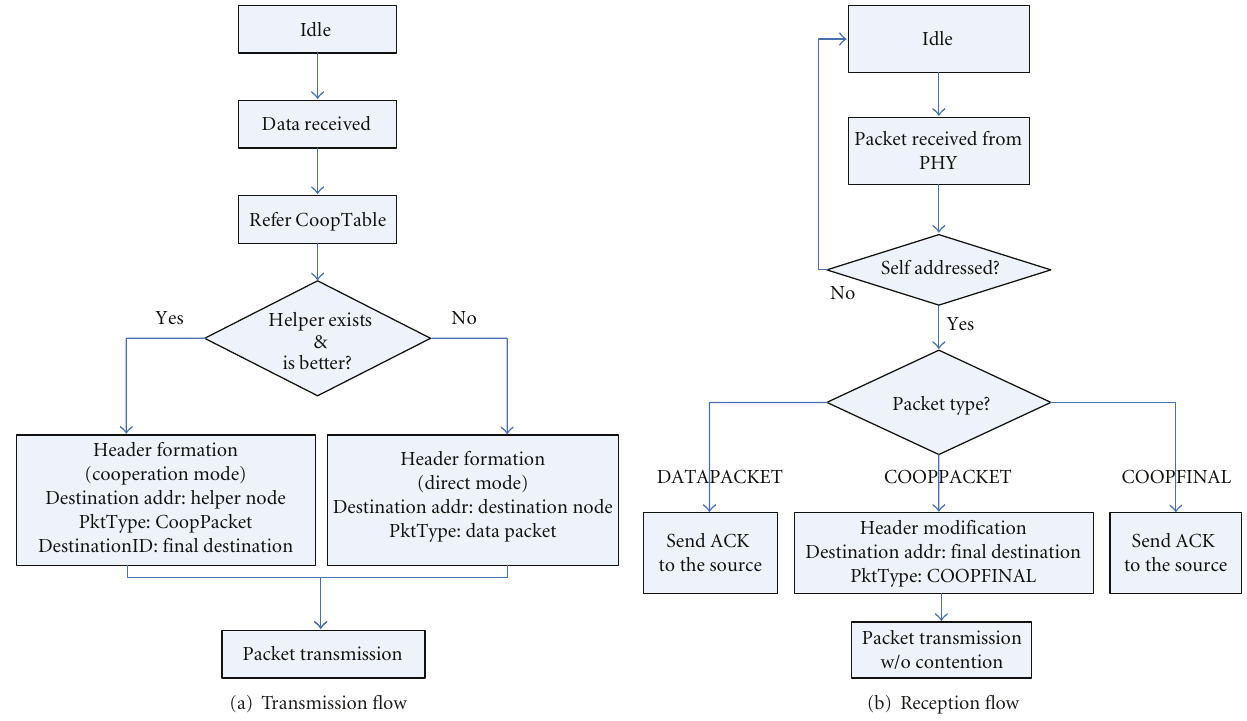
Figure 16: Simplified flow graphs of transmission and reception processes in CoopMAC.